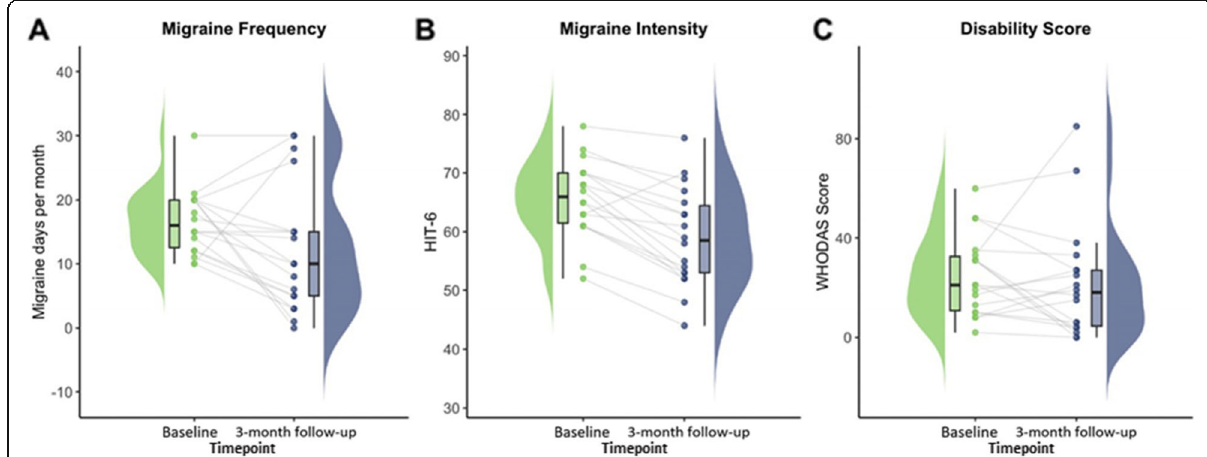
Fig. 2 Change in migraine characteristics from baseline to 3-month follow-up. Raincloud plots for change in A) migraine frequency (migraine days per month), B) migraine intensity (HIT-6 score) and C) disability (WHODAS score). Each individual plot represents change in clinical characteristics from baseline to 3-month follow-up in participants with migraine ( n = 18). Green data points represent migraine characteristics at baseline and blue at 3-month follow-up. The grey lines represent change in individual participants scores over time